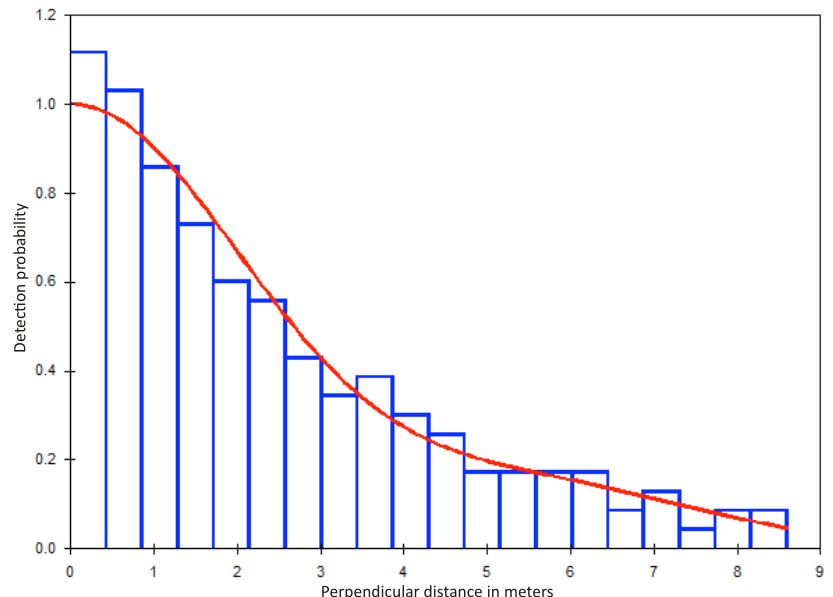
Perpendicular distance in Figure 2. Histogram produced by DISTANCE showing the perpendicular distances and the fitted visibility curve (half normal + cosine).